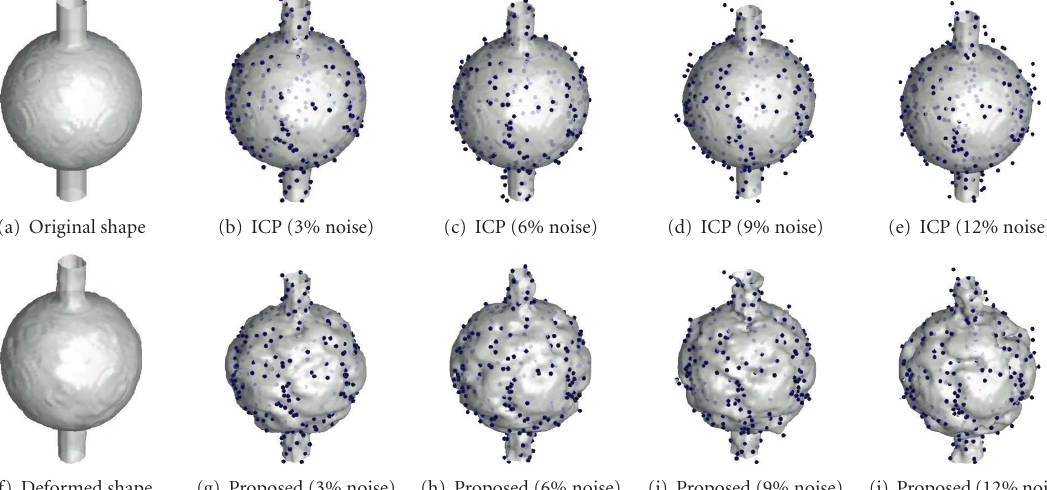
Figure 3: The shape reconstruction results for a synthetic 3D image: (a) the original shape, (b)–(e) ICP results using di ff erent Gaussian noise levels, (f) the deformed shape, and (g)–(j) results of the proposed method using di ff erent Gaussian noise levels.